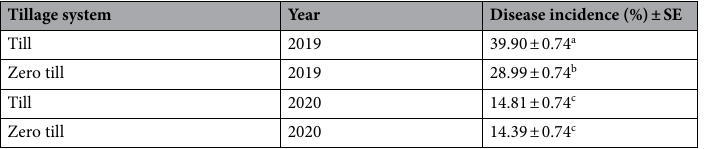
Table 3. Disease incidence in the tillage systems. SE Standard Error. a, b, c means in the same column with the same superscript are not significantly different at p < 0.05 (DMRT).